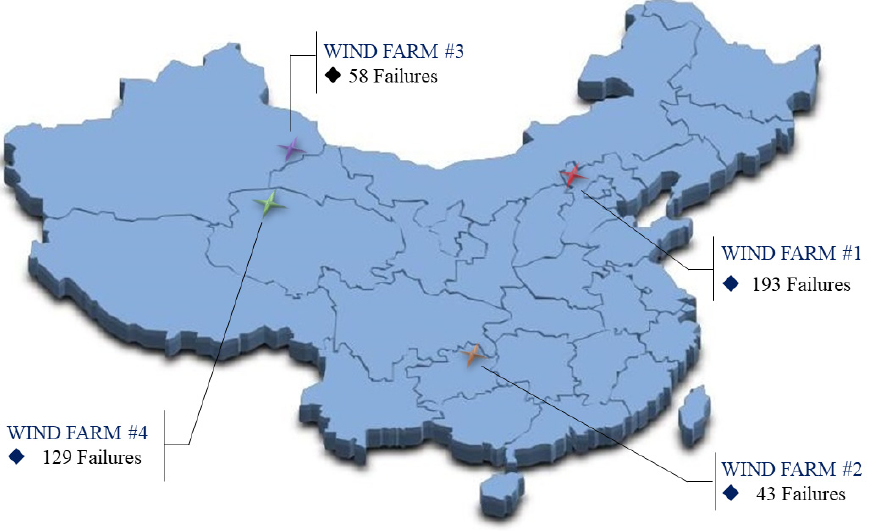
Figure 1. Wind farm locations in